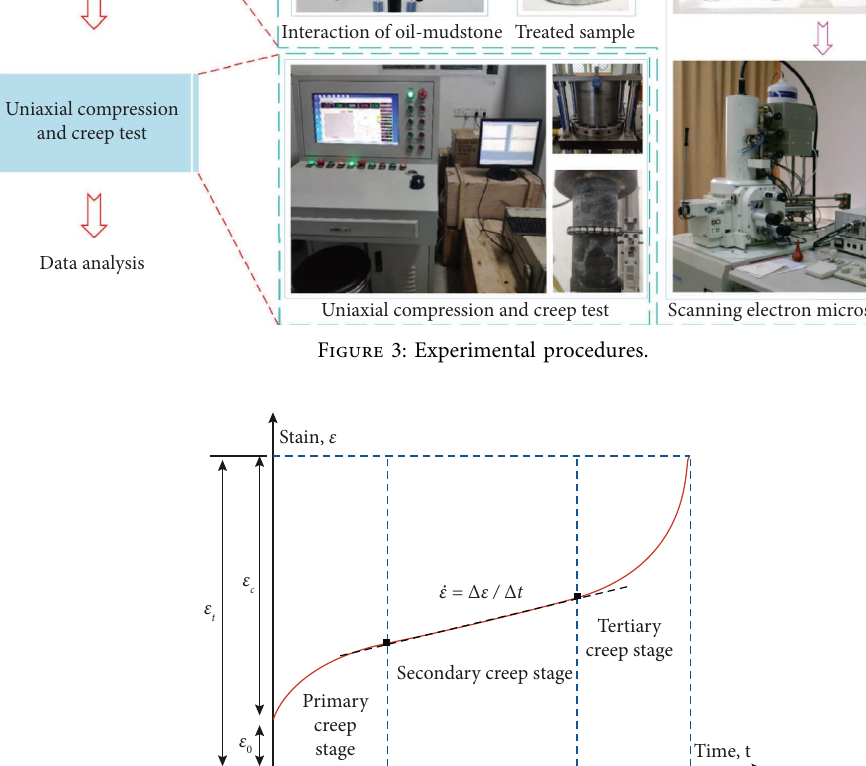
Figure 4: Typical creep curve of rock material